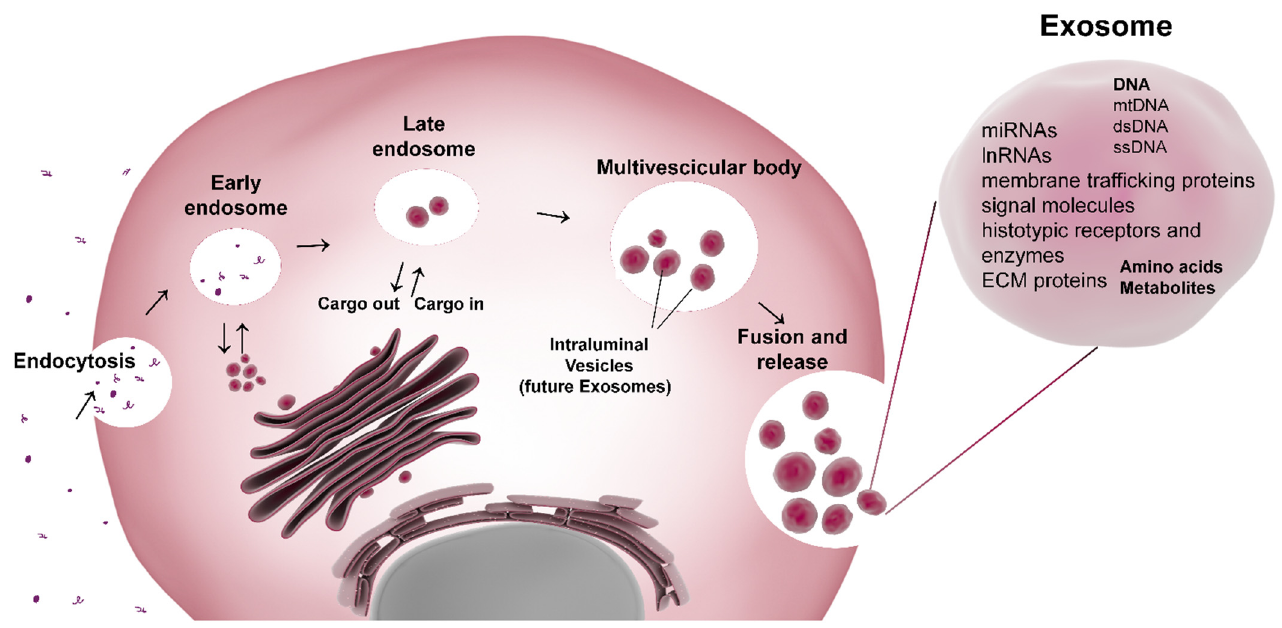
Figure 9. Exosome biogenesis. Through endocytosis and plasma membrane invagination, fluid and extracellular constituents such as proteins, lipids, metabolites, small molecules and ions can enter cells. This process leads to the formation of early endosomes or the possible fusion of the gem with endosomes performed by the constituents of the endoplasmic reticulum and of the Golgi network. Early endosomes give rise to late endosomes. Late endosomes evolve to multivesicular bodies (MVBs) with a defined collection of intraluminal vesicles (future exosomes). MVBs can also fuse directly with lysosomes for degradation (not shown). MVBs that do not follow this pathway can be transported to the plasma membrane. Exocytosis follows and leads to the release of exosomes with a lipid bilayer orientation similar to that of the plasma membrane. Exosomes can contain different types of cell surface proteins, intracellular proteins, RNA, DNA, amino acids and metabolites.